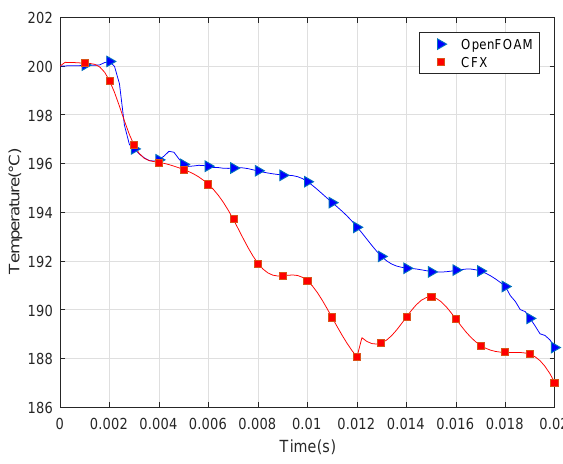
Figure 12. Temperature of the observation point in the PRT.